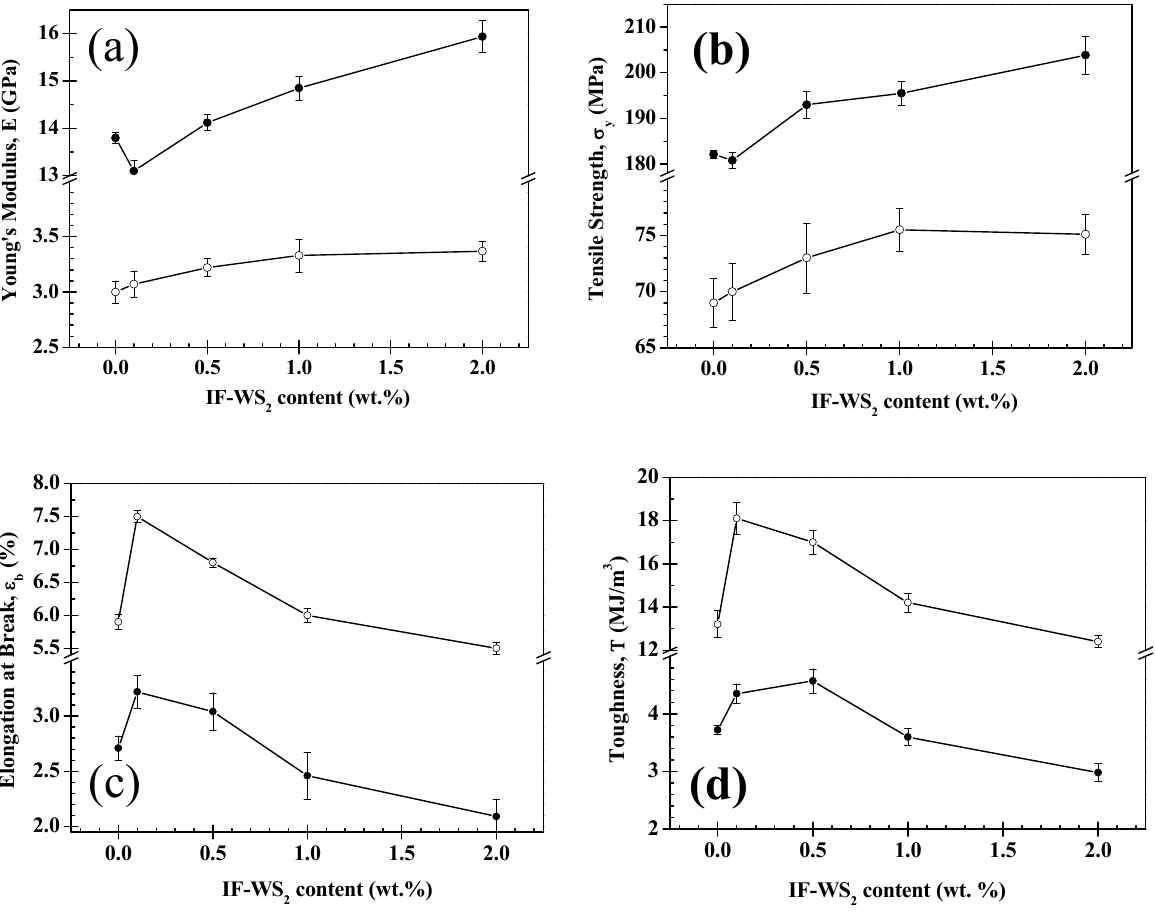
Figure 6. ( a ) Young’s modulus ( E ), ( b ) tensile strength ( σ and ( d ) toughness ( T ) as a function of IF-WS to PPS/IF-WS /CF and iPP/IF-WS 2